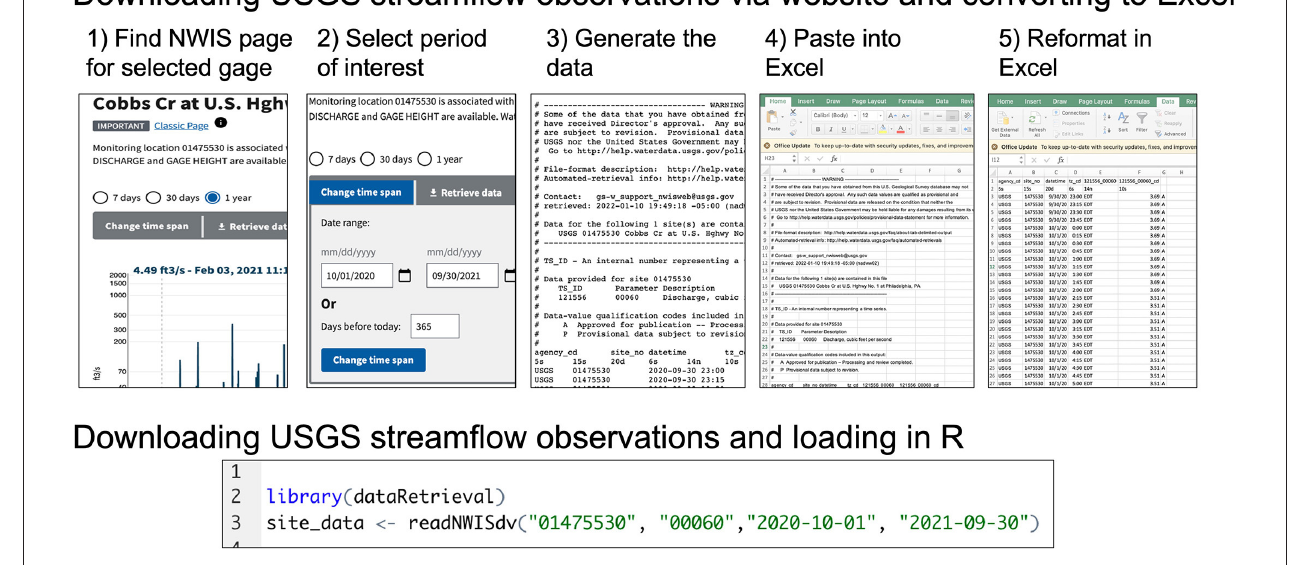
FIGURE 1 | Comparing the steps involved to generate streamflow observations for plotting in Excel (top) vs. two lines of code in R